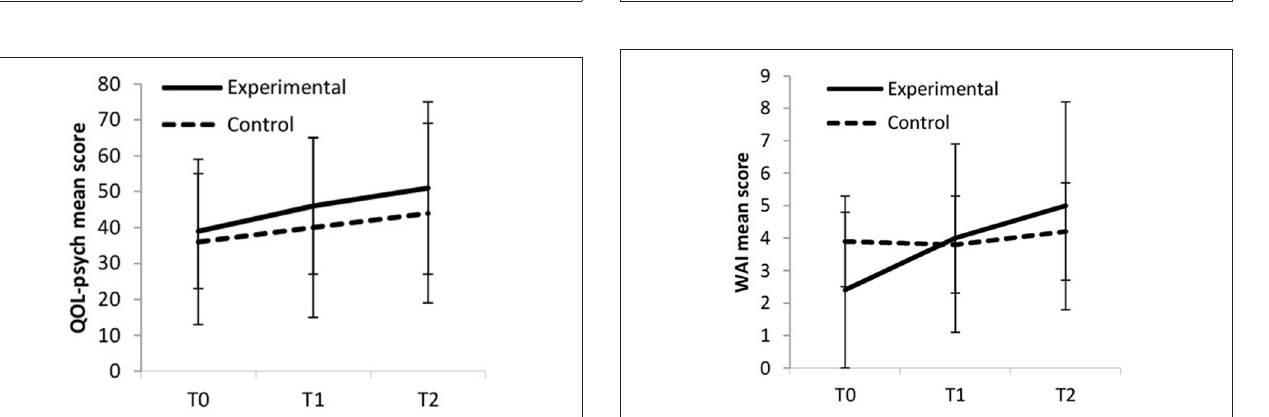
FIGURE 5 | Overall psychological strain (BSI-GSI).